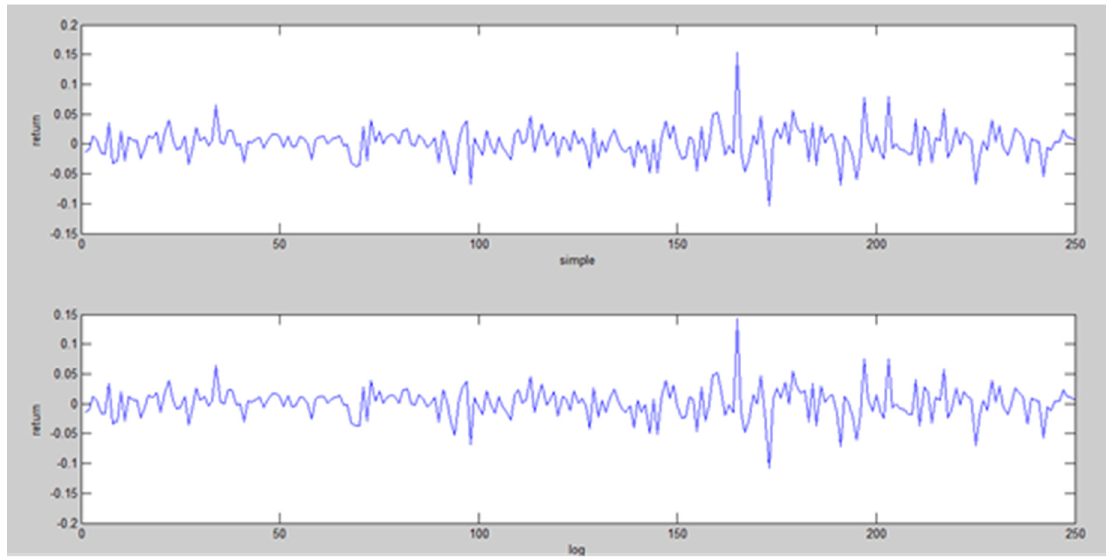
Figure 2. Time series plots of daily returns of Tableau data.